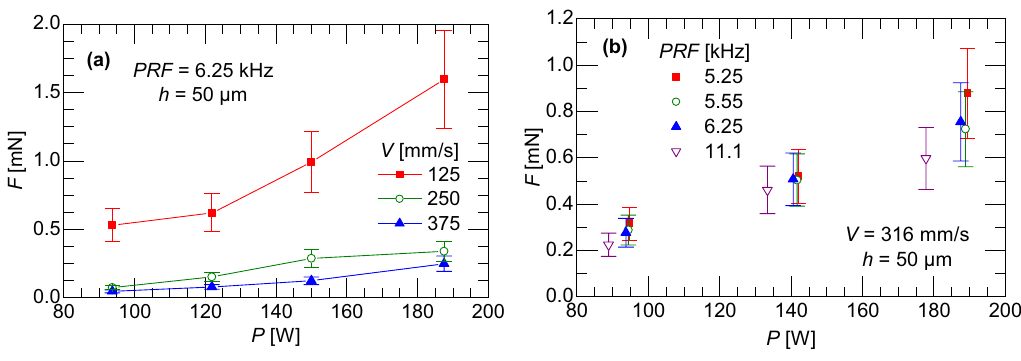
Figure 6. (a) Recoil force as function of laser power and scan speed for constant PRF and (b) recoil force as function of applied laser power for constant scan speed. Uncertainty is detailed in “Methods” section.